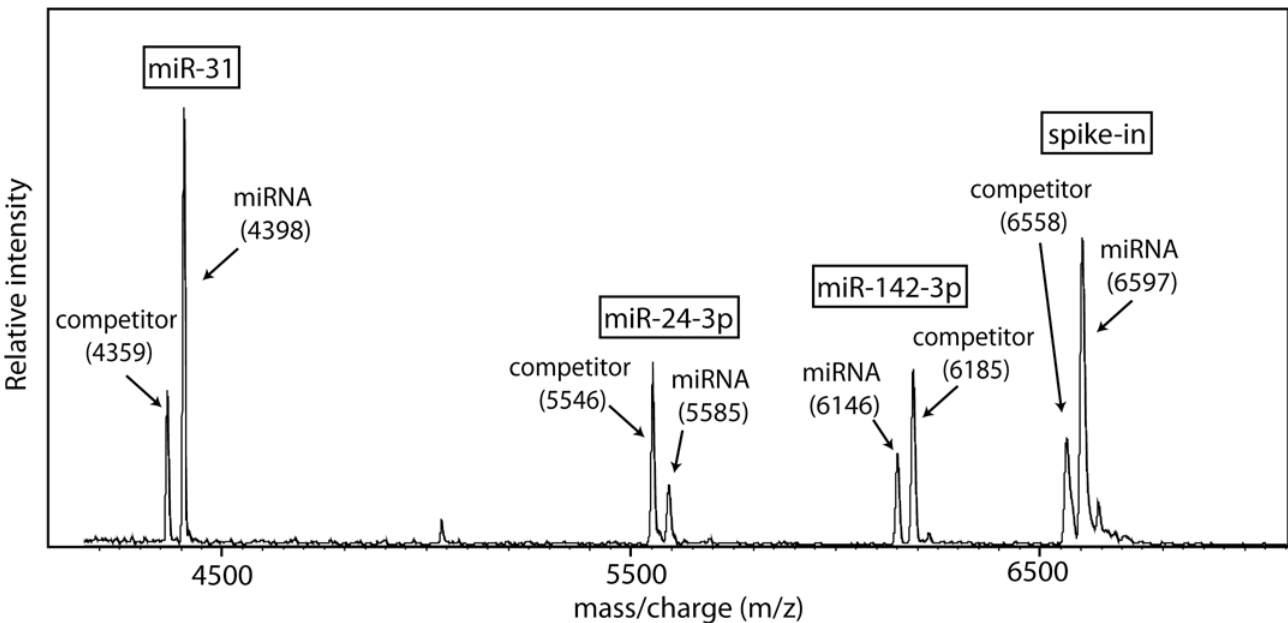
Fig 3. Mass spectrum for multiplexed analysis of four miRNA levels. Levels of cellular and spiked miRNA are determined using the peak area ratio and the initial concentration of the corresponding